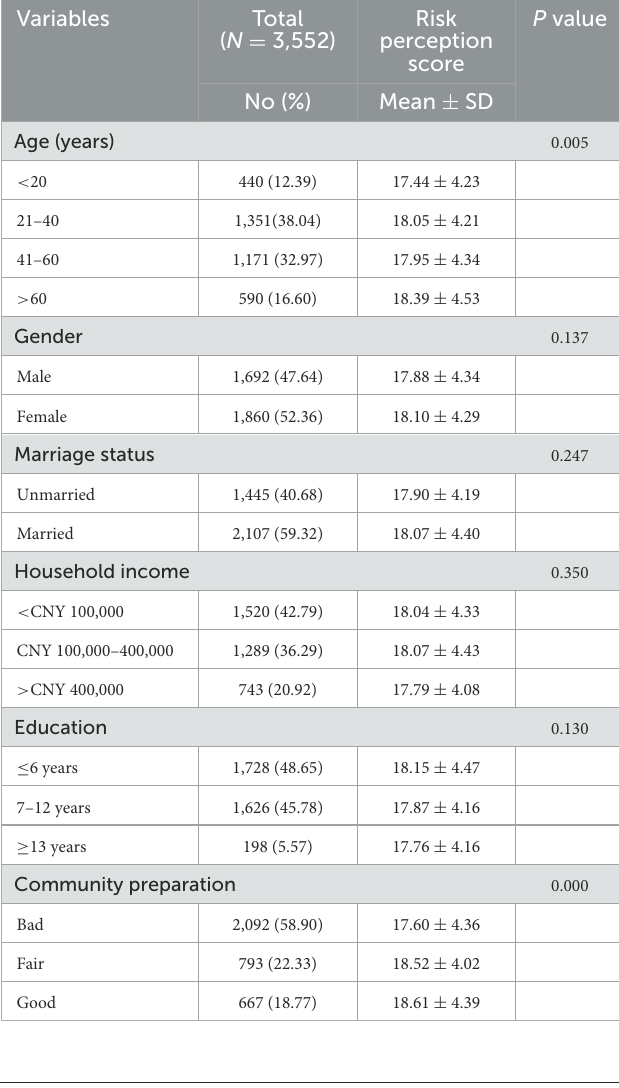
TABLE 1 Demographic characteristics of participants and risk perception score of COVID-19.